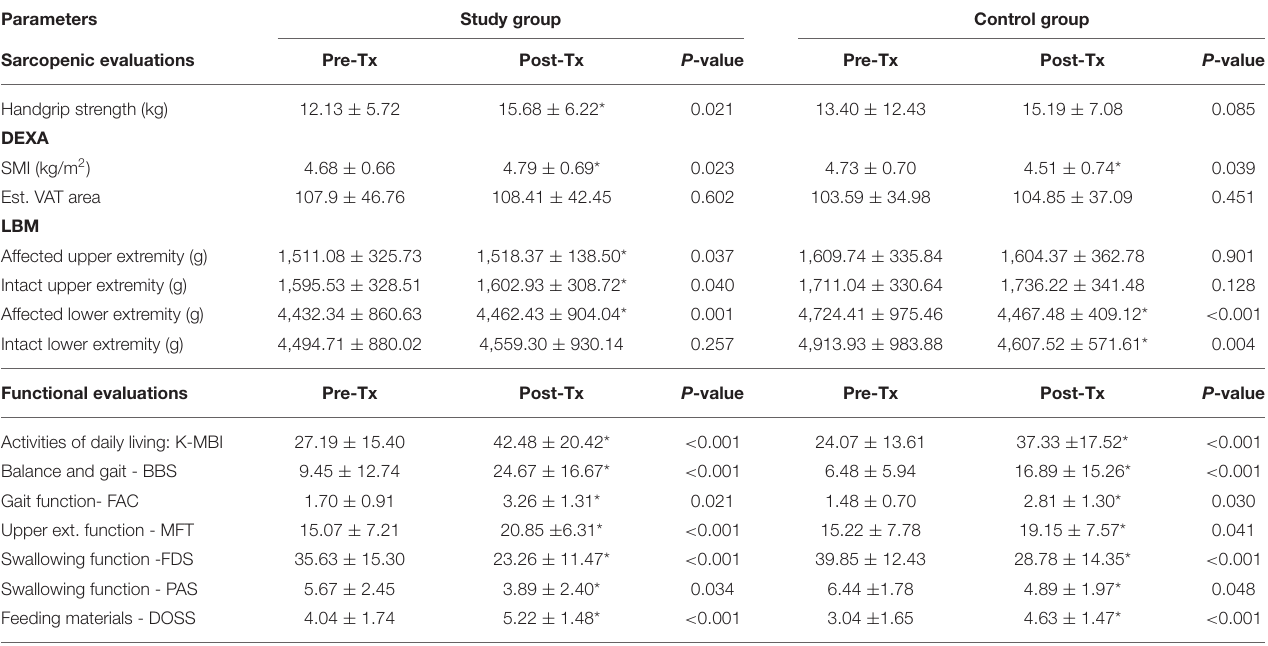
TABLE 2 | Sarcopenia and functional evaluations before and after treatment within the group.